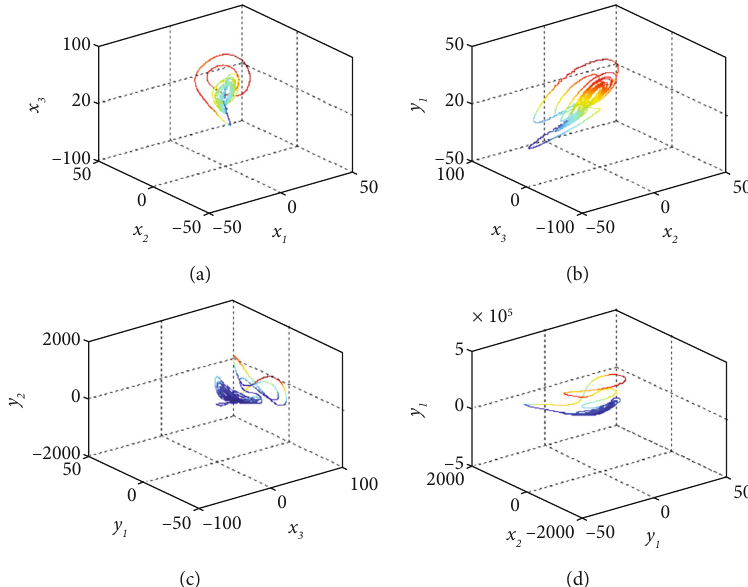
(cid:2) T , x + x 2 , x 3 1 2 2 3